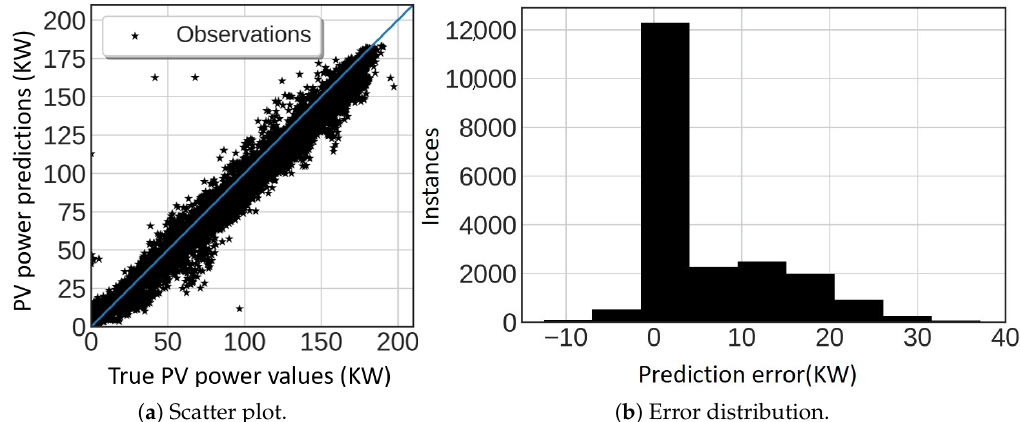
Figure 11. Scatter plots ( a ) and error distributions ( b ) of PV measured power and forecasted power.